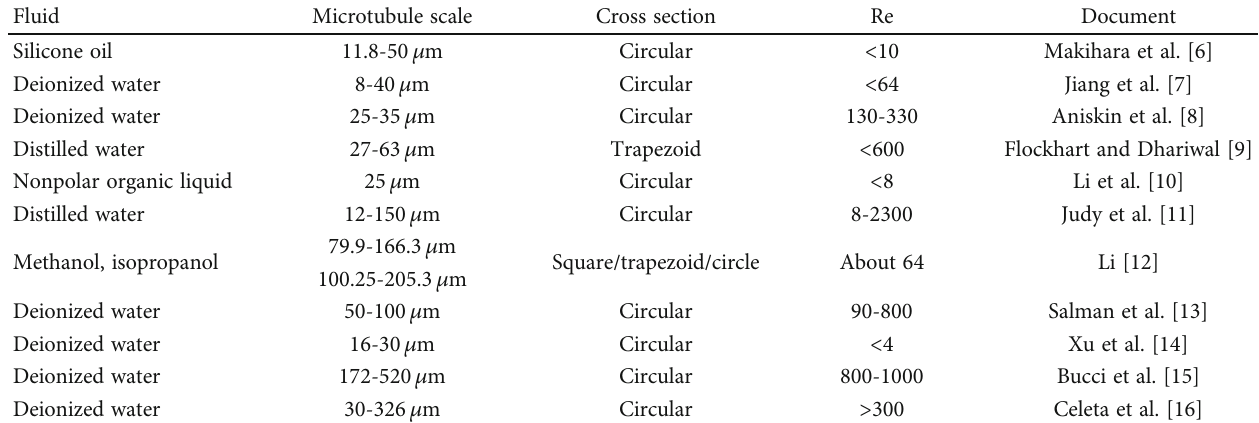
Table 1: Flow experiment in microcircular channel according to the N-S equation.